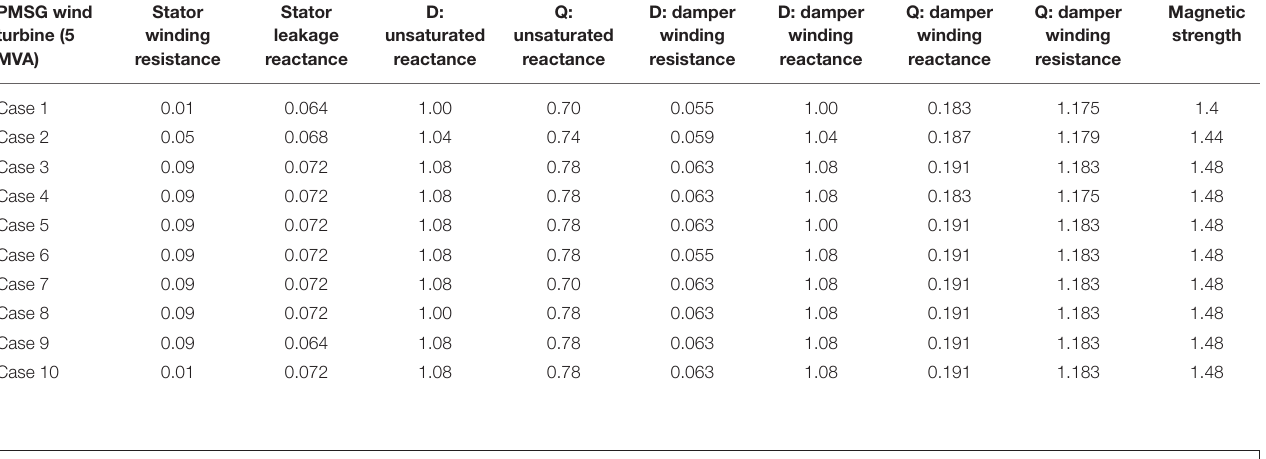
TABLE 2 | PMSG machine parameters (Hitachi Heavy Equipment Construction, 2012). PMSG wind turbine (5